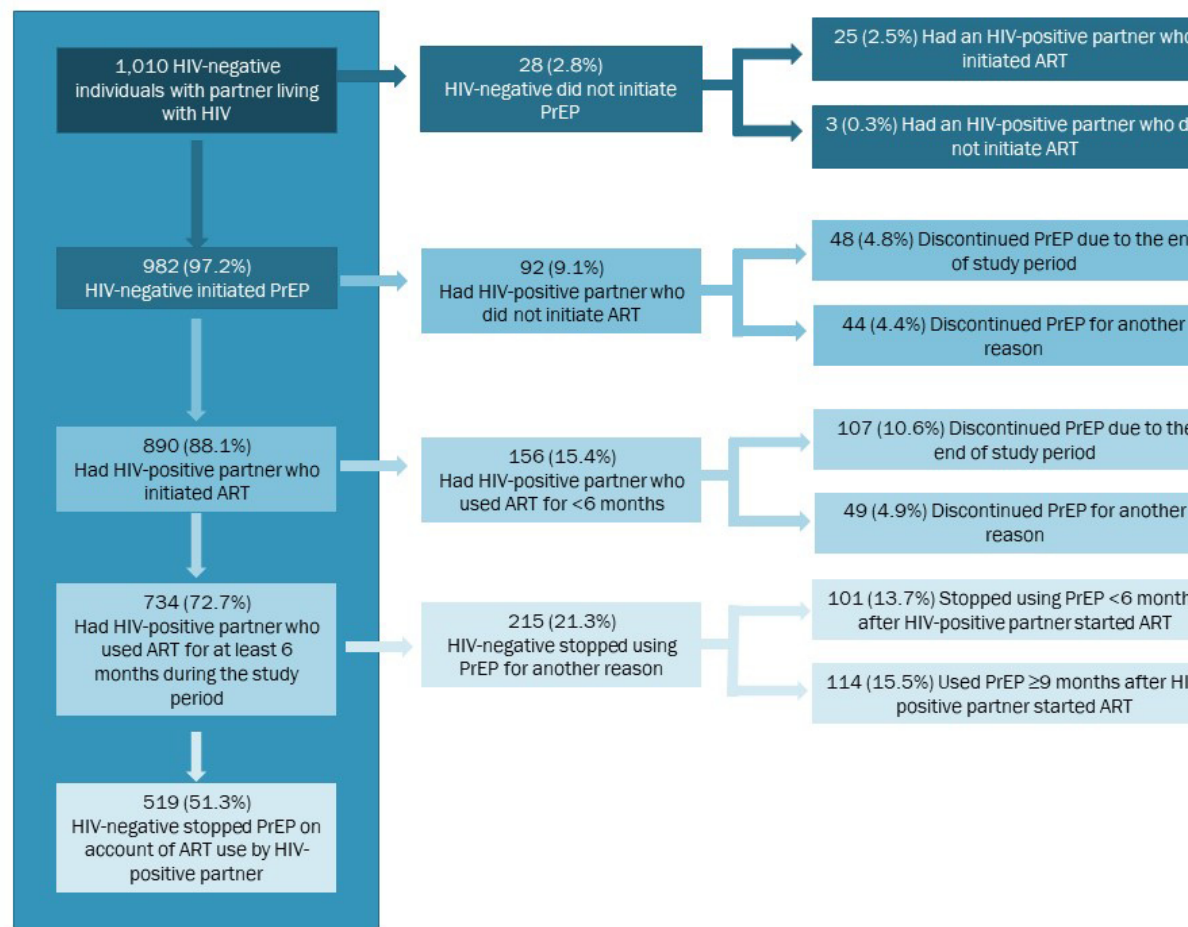
Figure 2. PrEP Use and Discontinuation by HIV-negative individuals with partners known to be living with HIV.